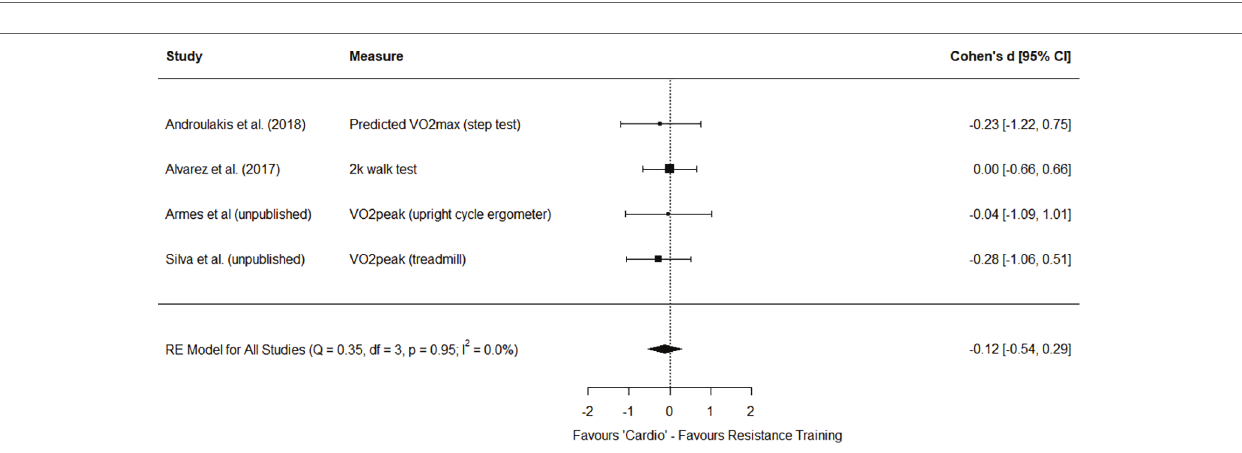
FIGURE 2 | Forest plot for multilevel (ML) mixed effects meta-analysis of strength outcomes from studies using effort matched designs to compare “cardio” and resistance training